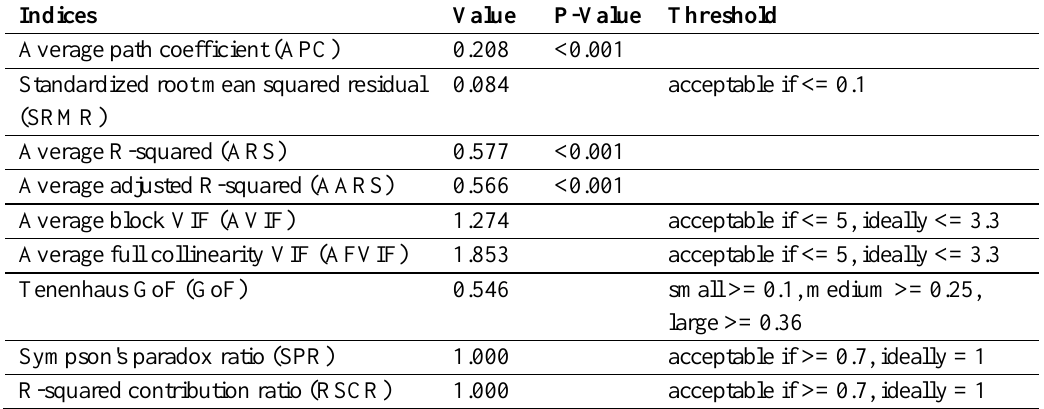
Table 4. Model Fit Indices with p-value and